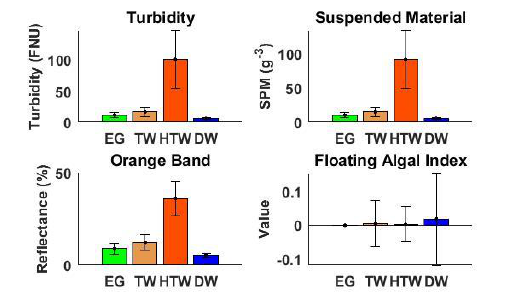
Figure 4. Mean values of the Acolite variables computed during the atmospheric correction for each class for both images Table 5. Confusion matrix for out-of-bag training pixels computed with the Random Forests classifier (bold values represent well-classified